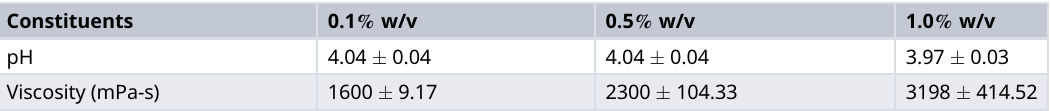
Table 4. The pH and viscosity of polymeric gel loaded with various strengths of gallic acid (mean (cid:1) SD, n = 3).